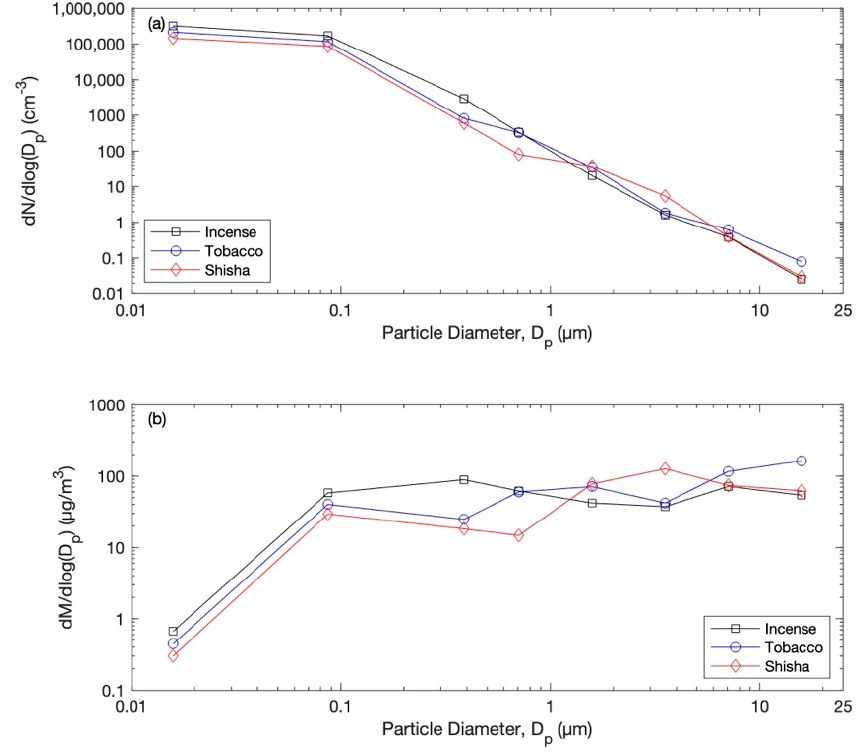
Figure 4. Overall mean ( a ) particle number size distributions and ( b ) corresponding mass size distributions by assuming spherical particles and unit density.